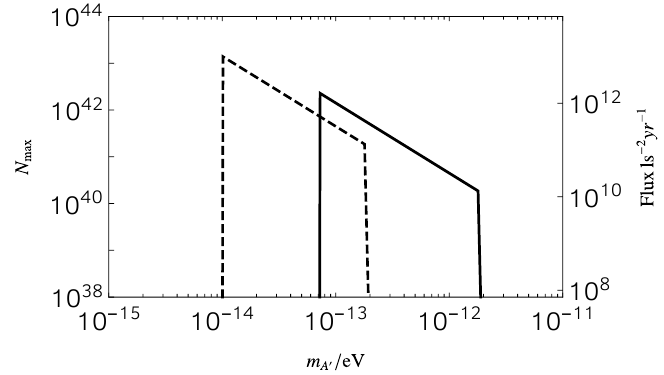
Figure 17 . Maximum number of vortex lines (left axis) and equivalent flux (in units of inverse light seconds squared per year, right axis) emitted in a stringy bosenova as a function of the dark photon mass. The solid and dashed lines correspond to black holes with masses of 10 and 100 M (cid:12) , respectively, with dimensionless spin χ BH = 0 . 5 when the stringy bosenova event happens. We take the quartic λ = 1 , and assume that the dark photon superradiance grows until the black hole spins down by ∆ χ BH = 0 . 1 for the azimuthal number m = 1 mode, and that the black hole was formed 10 6 years